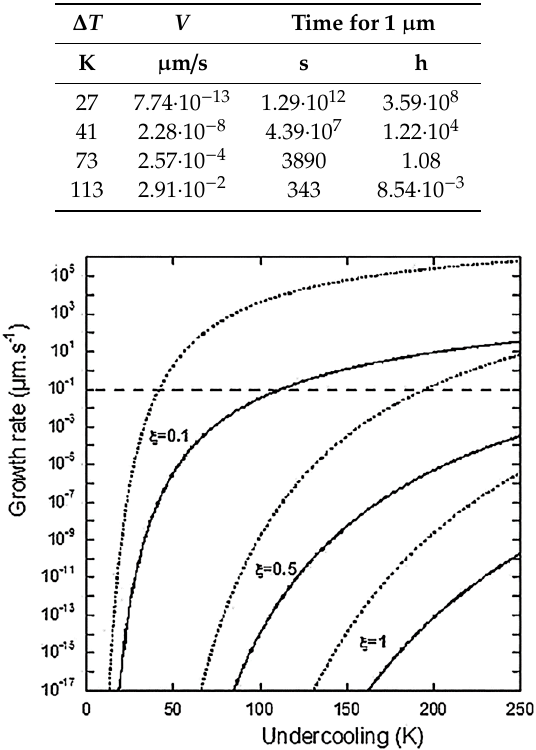
Figure 1. Overall growth rate of a graphite spheroid according to the PNG model as a function of undercooling, for three values of ξ . Dotted lines are according to Equation (17) in ref. [3] and solid lines are according to Equation (29) in ref. [3].